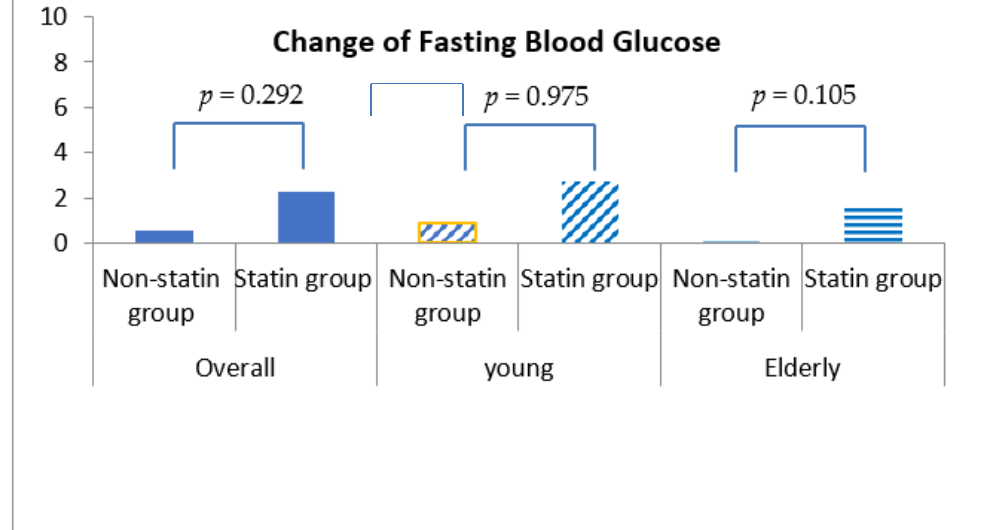
Figure 1. Changes in fasting blood glucose levels among non-statin and statin users overall and in young and elderly cohorts after propensity score matching.